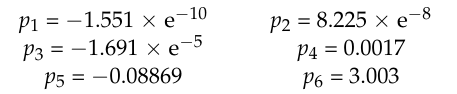
Table 2. Results of the polynomial.